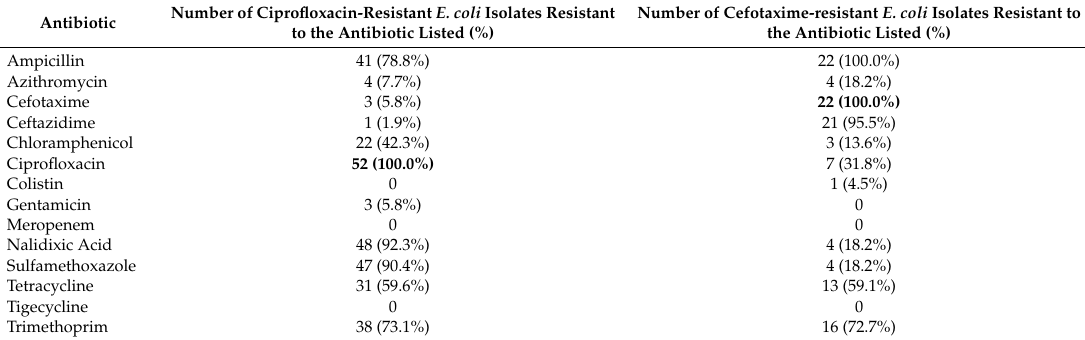
Table 4. Number and percentage of ciprofloxacin or cefotaxime-resistant E. coli isolates resistant to the antibiotics tested in the EUVSEC